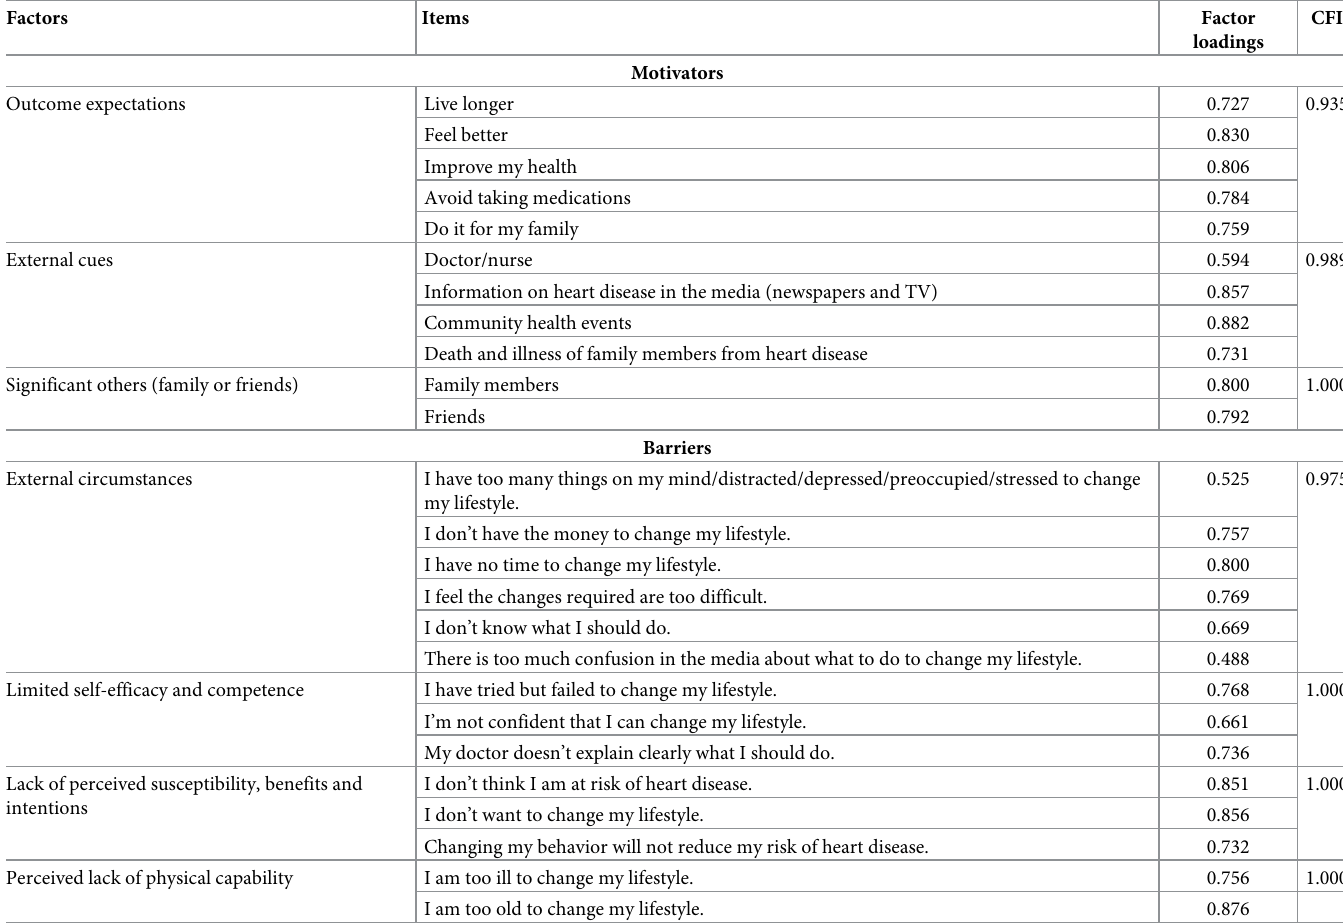
Table 2. Exploratory and confirmatory factor